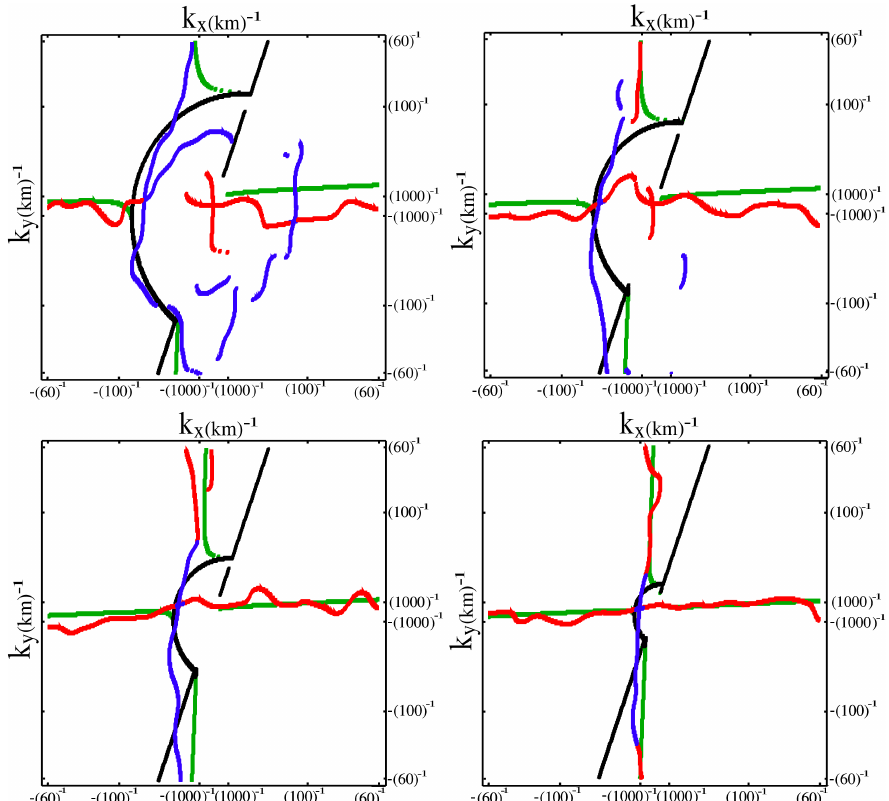
Fig. 4. Left to right, top to bottom, four ( k x ,k y ) sections of P(k x ,k y , ω ) for ω =2, 3, 5 and 10 hr − 1 , origin in the centre. The black line is the theoretical singularity (dispersion) curve ( |˜ g wav | 2 with ˜ g wav from Eq. 19), the blue the empirically estimated curve using the ad hoc algorithm, and the green and red show maxima but are presumed to originate in the turbulence “background” (they are very close to the